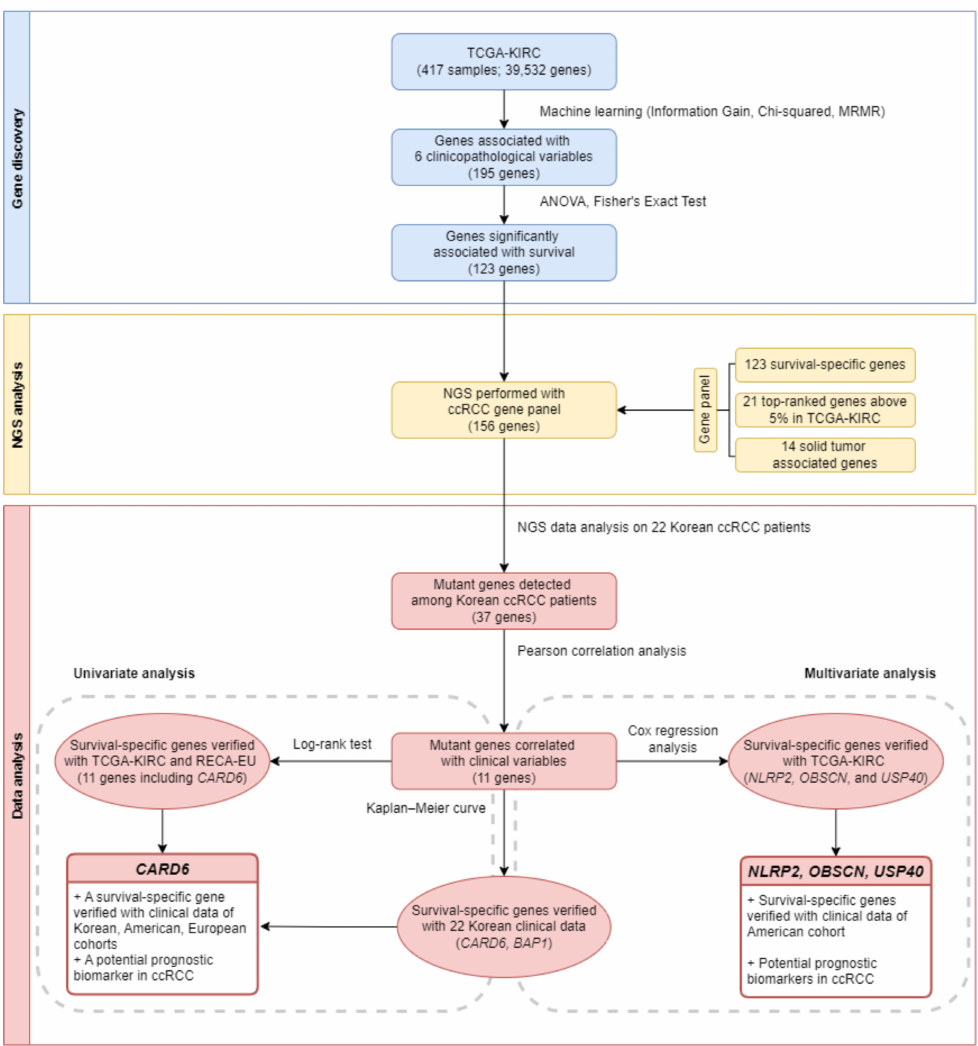
Figure 1. Workflow of the study. NGS, Next Generation Sequencing; TCGA-KIRC, The Cancer Genome Atlas Kidney Renal Clear Cell Carcinoma; MRMR, Minimum Redundancy and Maximum Relevance; ANOVA, Analysis of variance; ccRCC, clear cell renal cell carcinoma; RECA-EU, Renal Cell Cancer-European